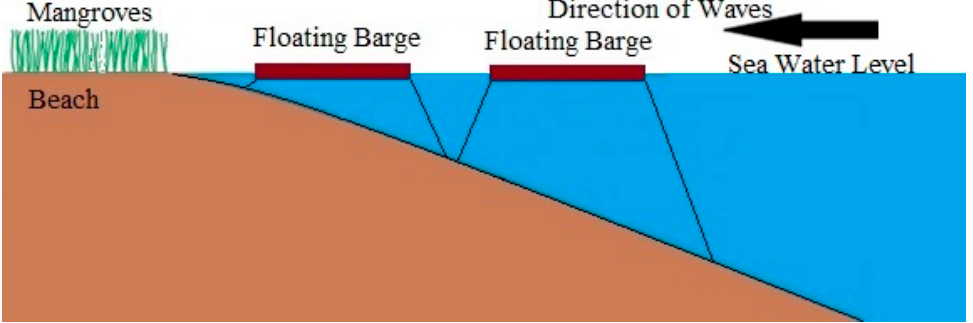
Figure 8. Moored barges in a series with mangroves planted on the beach.